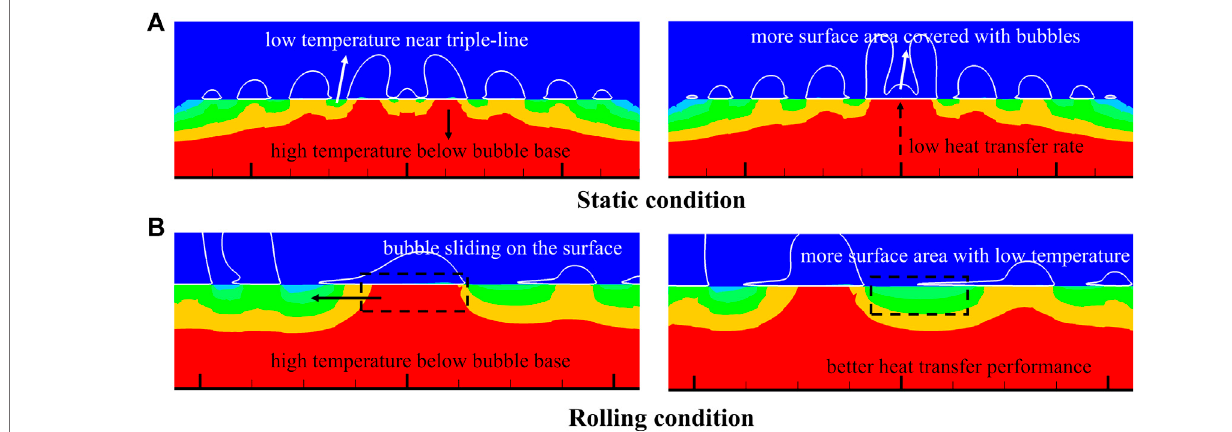
FIGURE 8 | Temperature fi eld inside the heater surface during bubble growth or sliding.